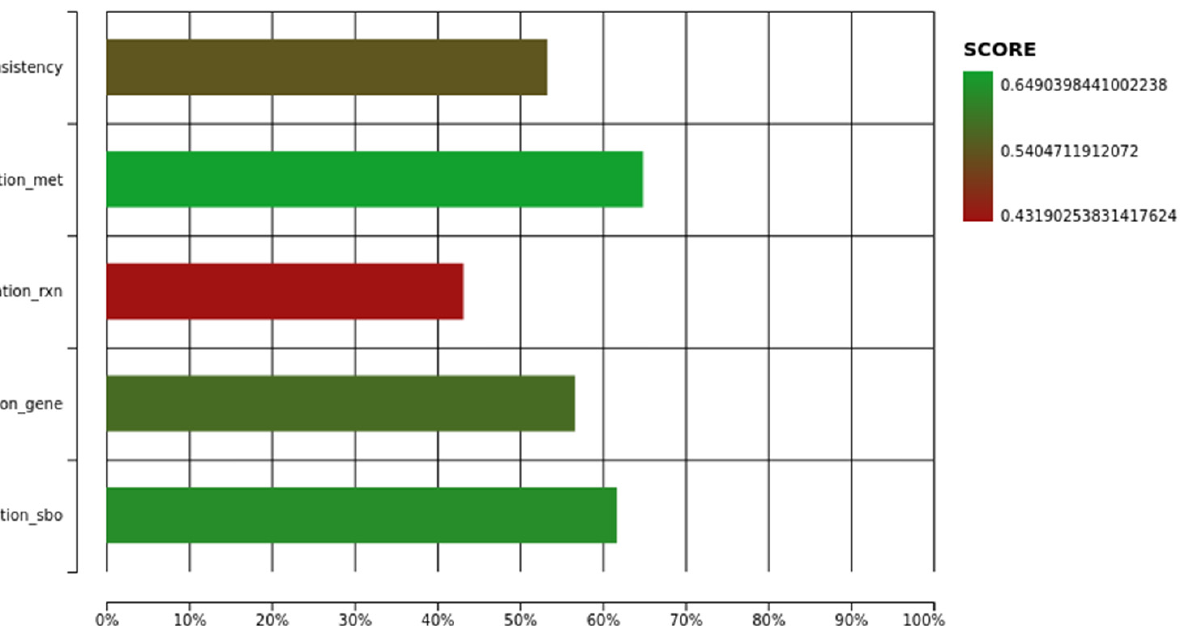
Table 2. Number of metabolites, reactions, and genes of the genome-scale metabolic model of U. maydis iUma22 and, in comparison, the community yeast model (8.5.0 [42]).